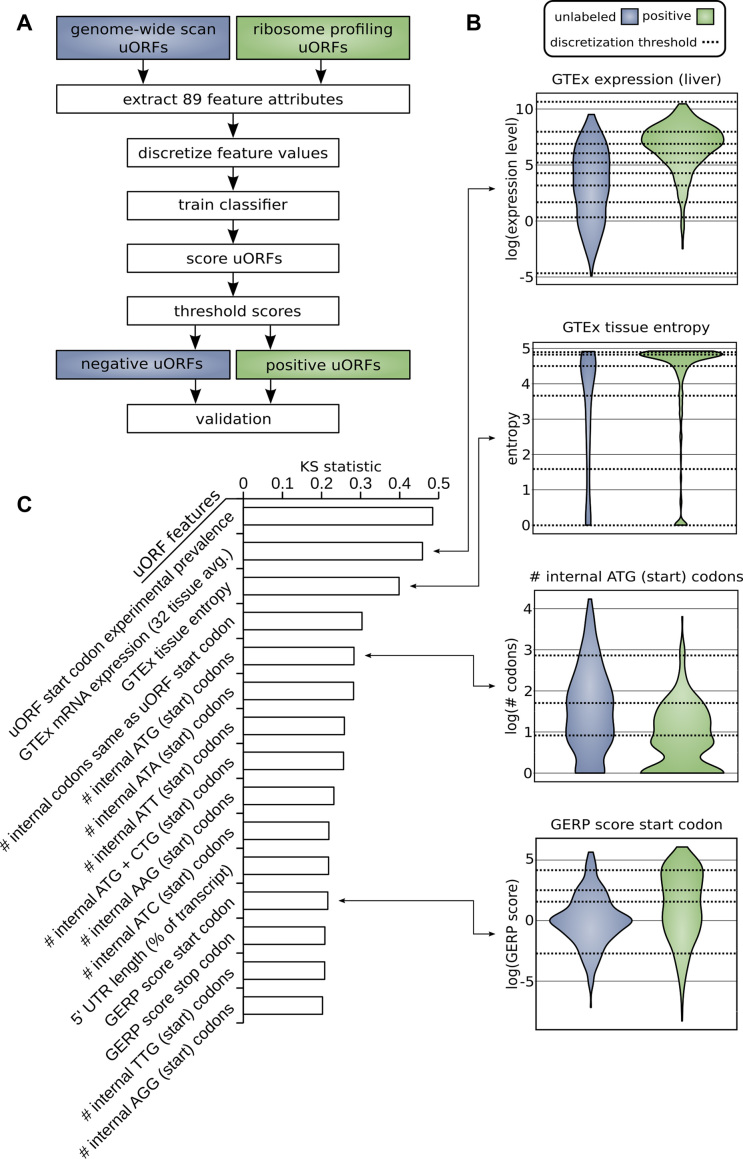
(A) Methodology for distinguishing positive from unlabeled uORFs. uORFs identified through genome-wide scan and uORFs labeled in ribosome profiling experiments were used to train a machine learning algorithm to identify uORFs that are likely active (positive predictions). (B) Examples of differential distributions of attributes between positive and unlabeled uORFs. uORF attributes are used to distinguish positive from unlabeled uORFs. Continuous distributions were discretized and optimized for machine learning using the minimum description length principle (MDLP) binning algorithm. Horizontal lines on the plot correspond to these binning intervals. (C) Upstream open reading frame attribute ranking. Attributes are ranked according to the difference in distribution between positive and unlabeled uORFs using the KS statistic. The top 15 features according to this prioritization are shown.